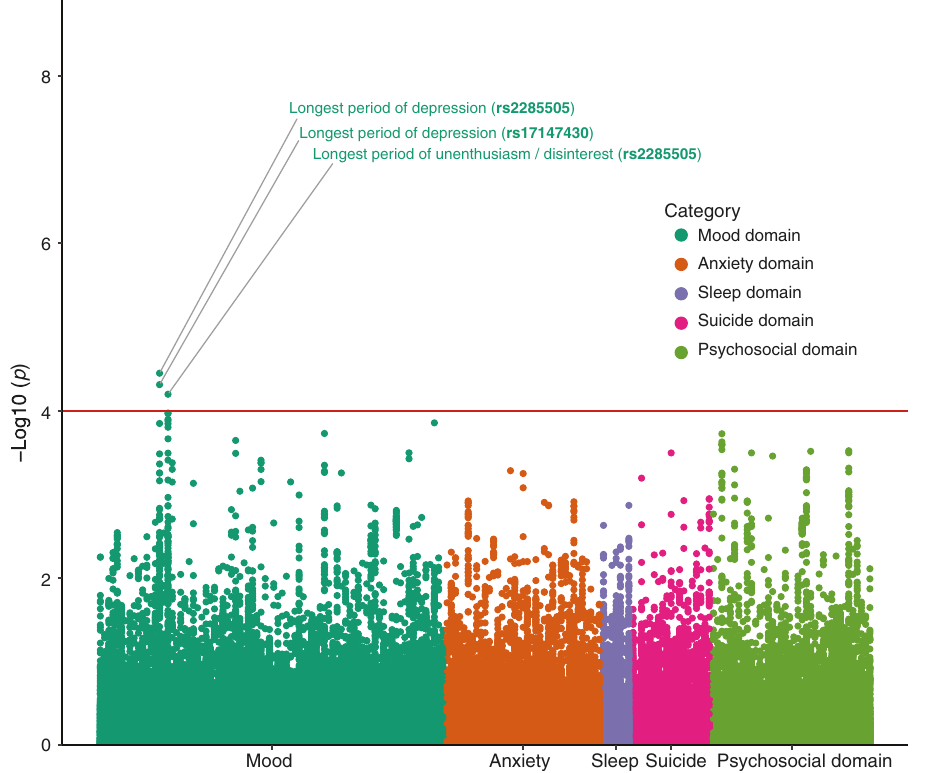
Fig. 5 Manhattan plot of the probability for VPS50 variants in association with fi ve domains related to major depression. Two hundred seventy-three SNP (single nucleotide polymorphism) variants in human VPS50 gene (human homolog of mouse Blm ) derived from UK Biobank (https://www.ukbiobank.ac.uk/) were analyzed for fi ve domains (mood, anxiety, sleep, suicide, and psychosocial factors) related to major depression that containing 183 traits in total. SNP variants with association p < 1 × 10 − 4 and r 2 < 0.5 were considered as signi fi cant signals. Two variants rs2285505 and rs17147430 are signi fi cantly associated with mood